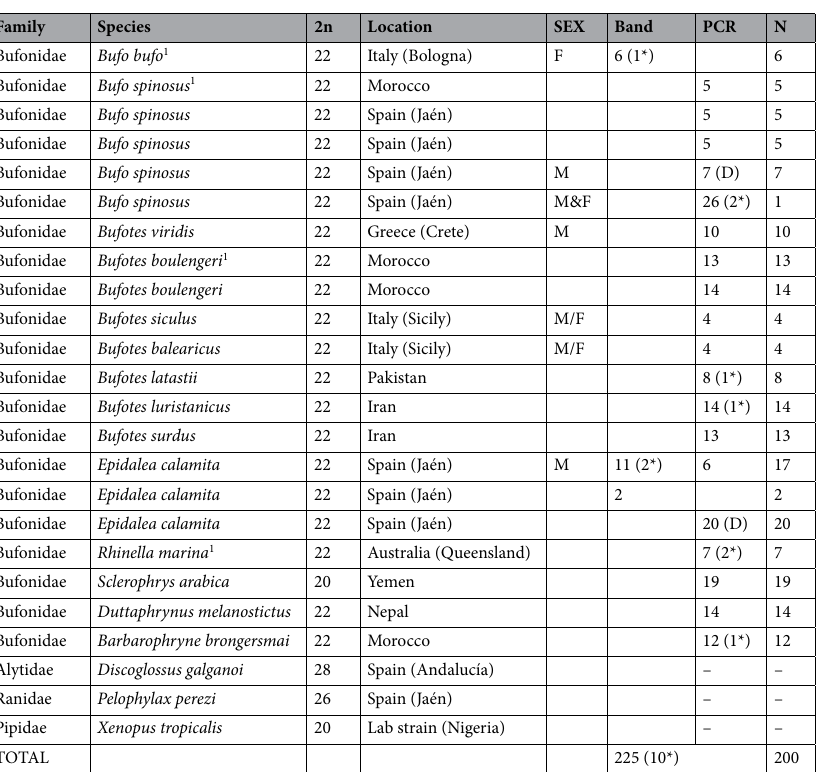
Table 1. Samples analysed in this study. For each sample, the following information is provided: anuran family, species name, chromosome number, geographical origin of the sample, sex (if known), number of sequences obtained from digested DNA (band), number of sequences obtained from specific PCR (PCR), and number of sequences used in the phylogenetic analysis (N). (D): monomer sequences from dimers of ca. 1600 bp; (*): incomplete fragments. 1 Samples from tissue